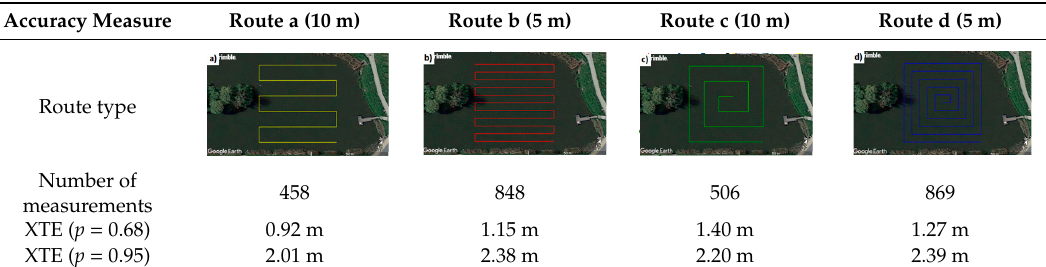
Table 2. Statistical accuracy measures (XTE) of steering an USV for particular routes.